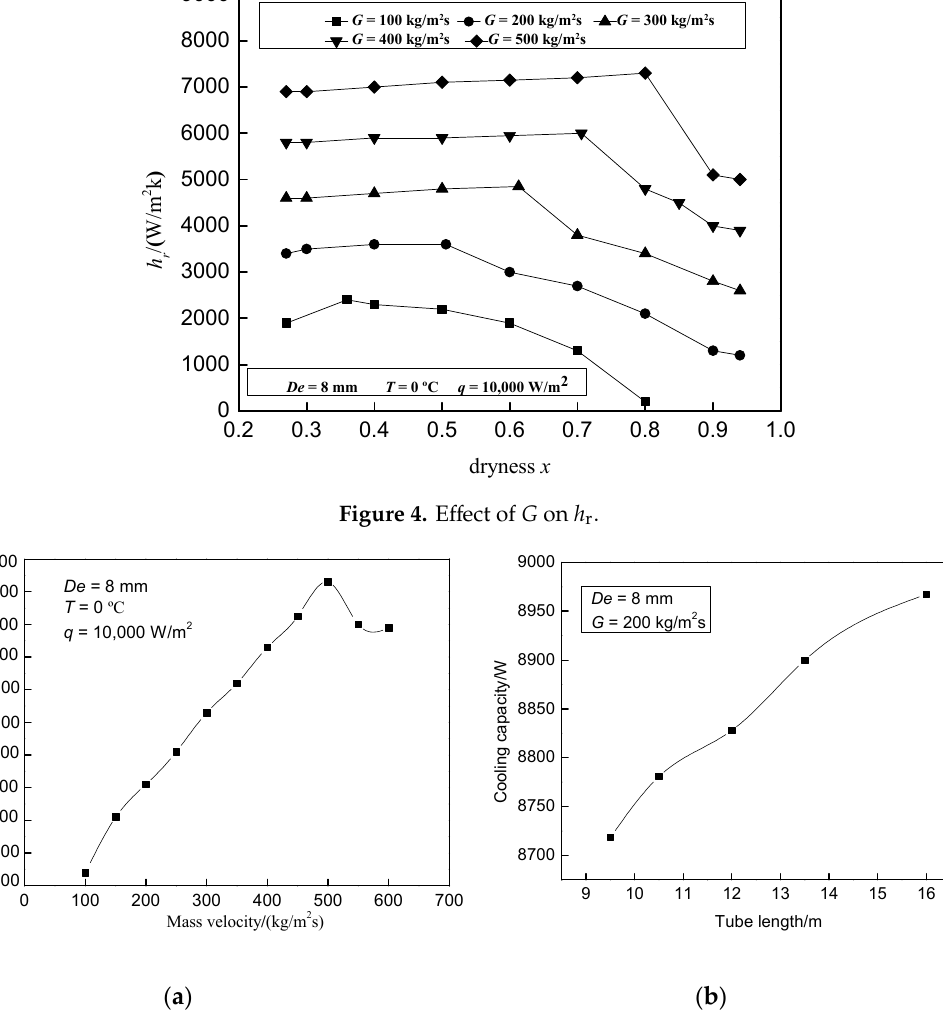
Figure 5. Effect of G on cooling capacity.